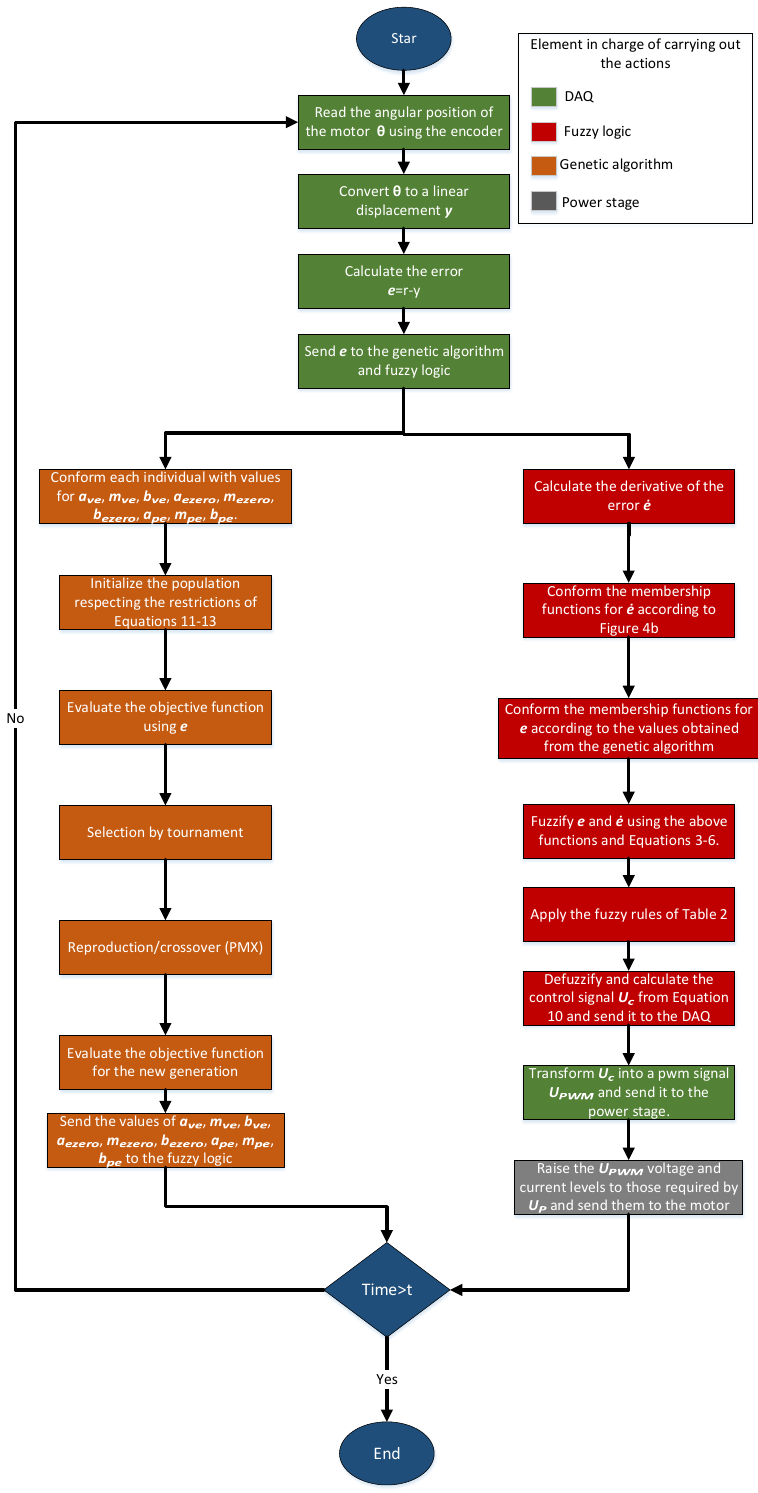
Figure A1. Flowchart designed for the